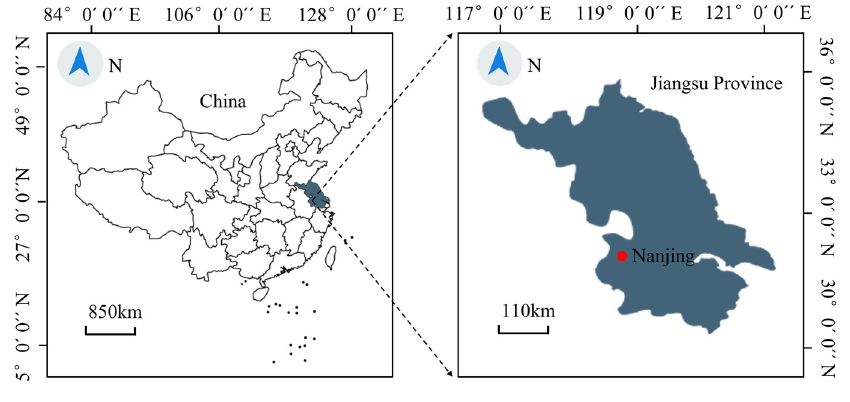
Figure 13. Sampling region.